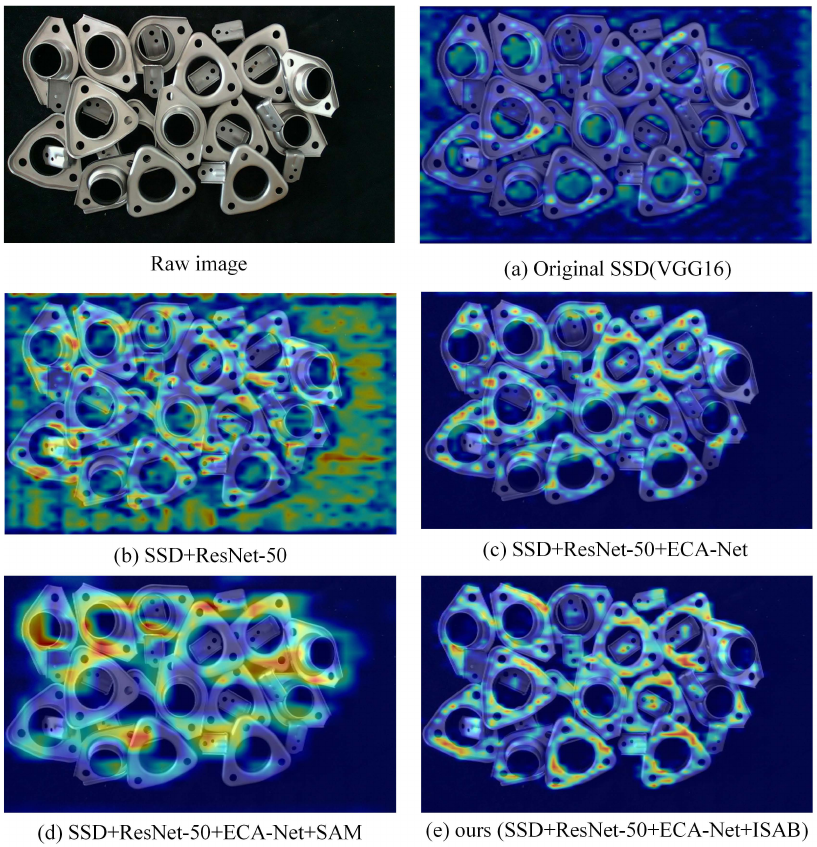
Figure 9. Heatmap of network learning area before and after improvement. (The brighter areas in the graph represent the higher weights assigned by the